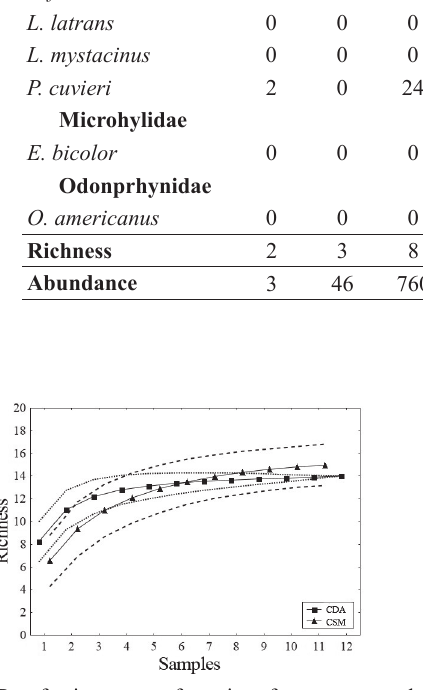
An Acad Bras Cienc (2016) 88 (3 Suppl.)